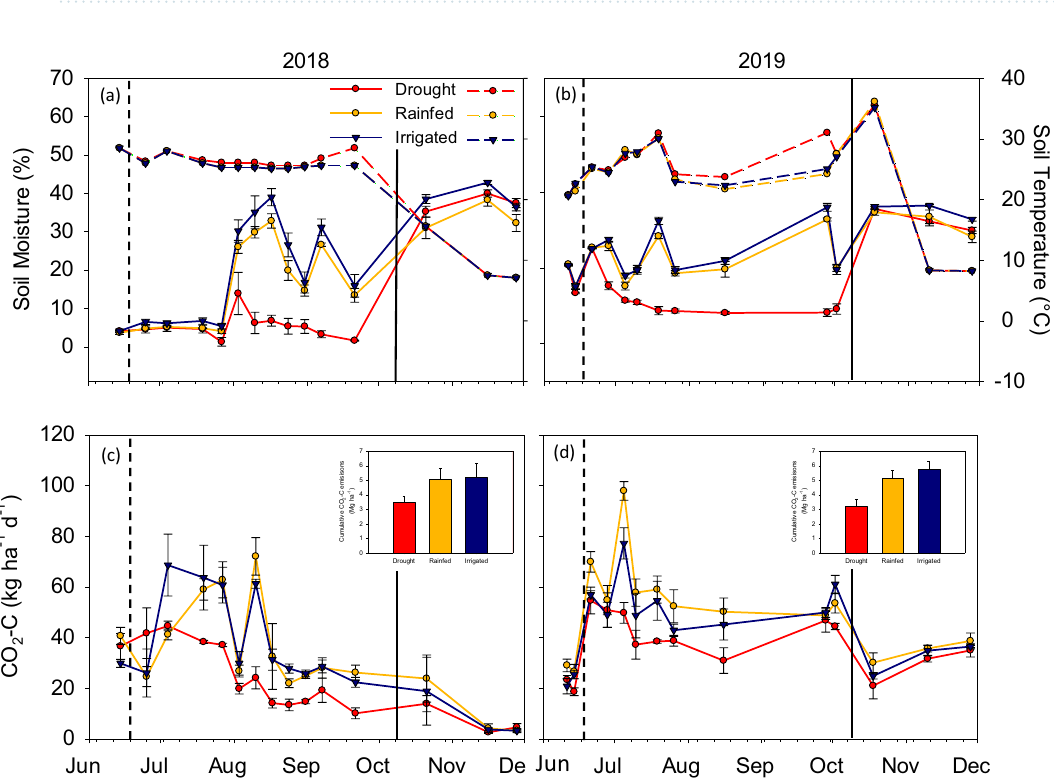
Figure 3. Soil temperature and soil moisture (0–5 cm) as influenced by moisture treatments in 2018 ( a ) and 2019 ( b ). Dashed line in the legend represents the soil temperature and solid line represents the soil moisture. Daily CO 2 fluxes during the growing season in 2018 ( c ) and 2019 ( d ). Legend for daily CO 2 fluxes is same as soil moisture. Vertical dashed line represents shelter establishment date and solid line represents shelter removal date. Inset: cumulative CO 2 emissions during the growing season. Error bars represent standard error (n =